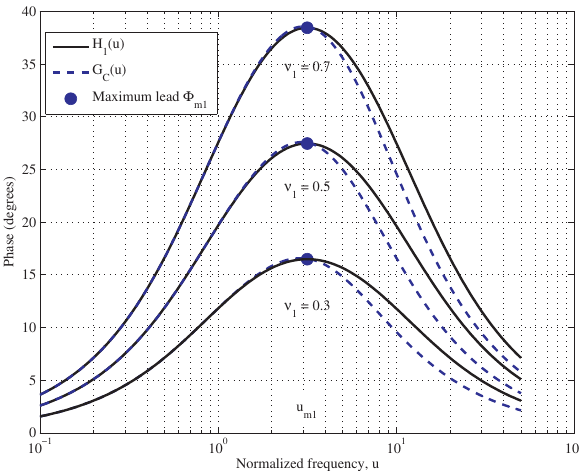
Figure 2. Bode phase diagrams of the FLECs H 1 ( ju ) (solid lines) and of the second-order realizations G CH 1 ( ju ) (dashed lines) for ν 1 =